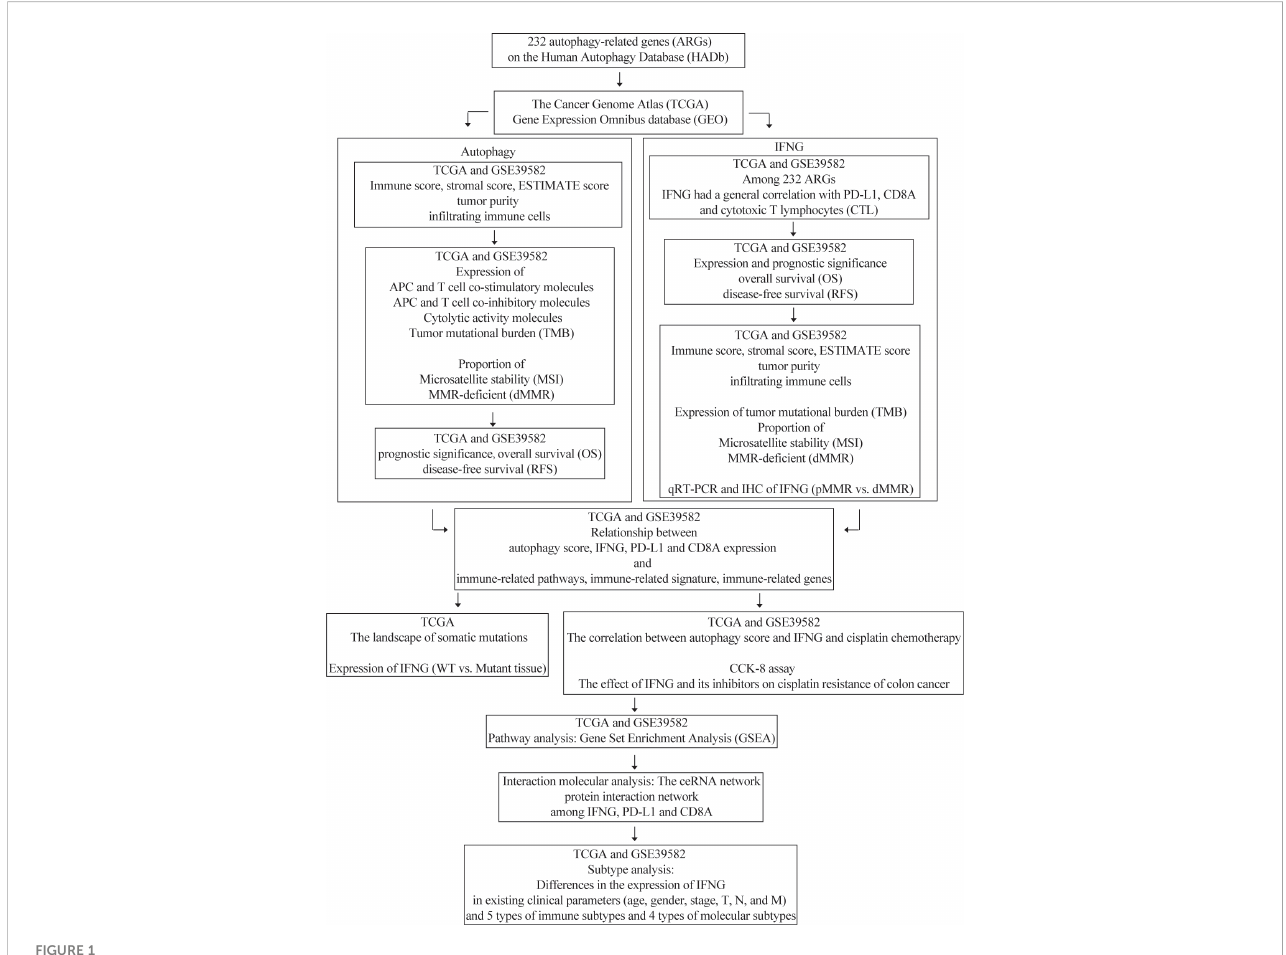
FIGURE 1 The fl ow chart of our